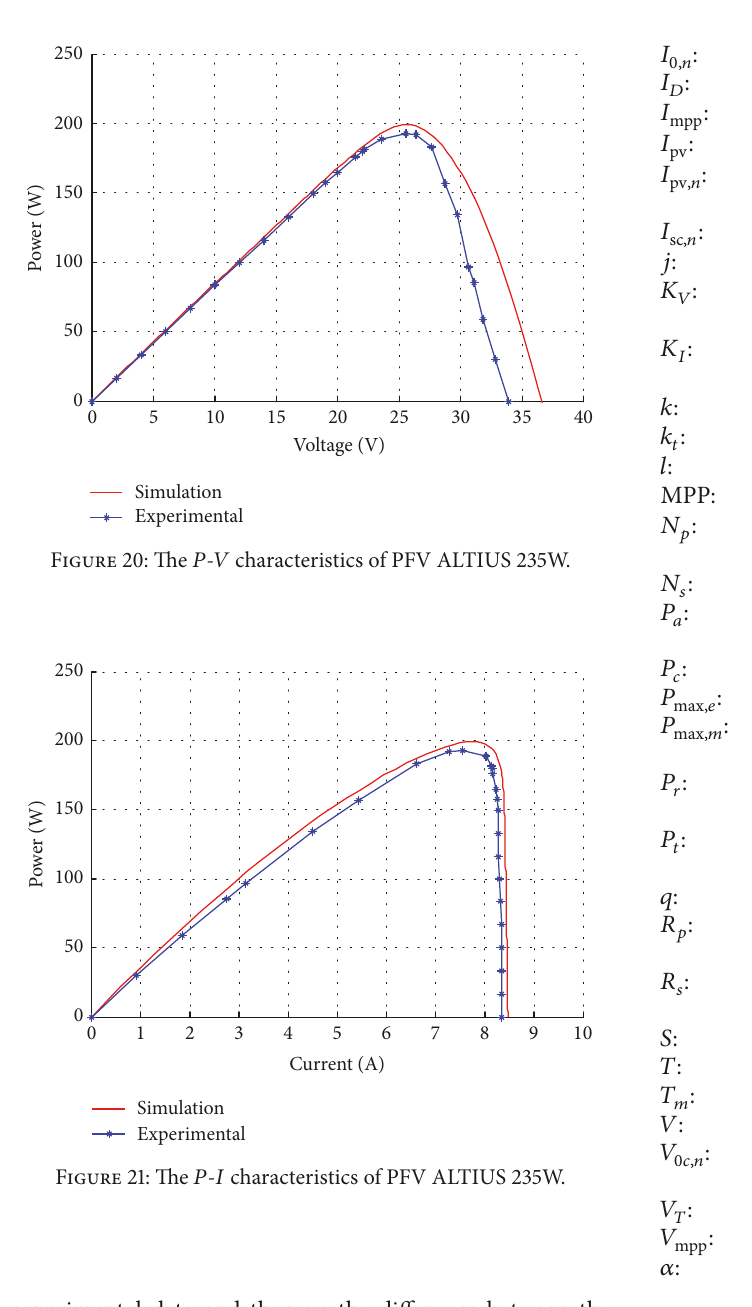
experimental data and thus on the difference between the simulated data and the